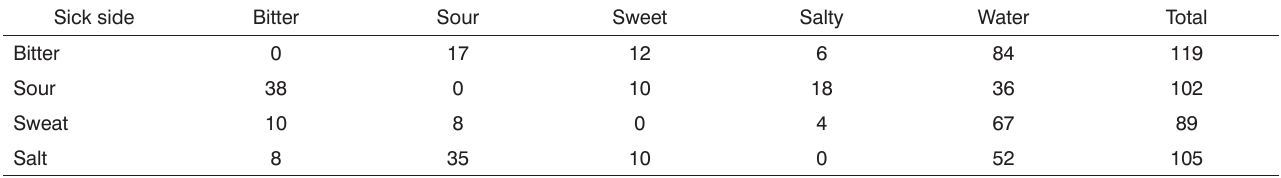
Table 3. Number or errors for each taste offered (horizontal bar) on the sick side and the number of wrong answers (horizontal bar).